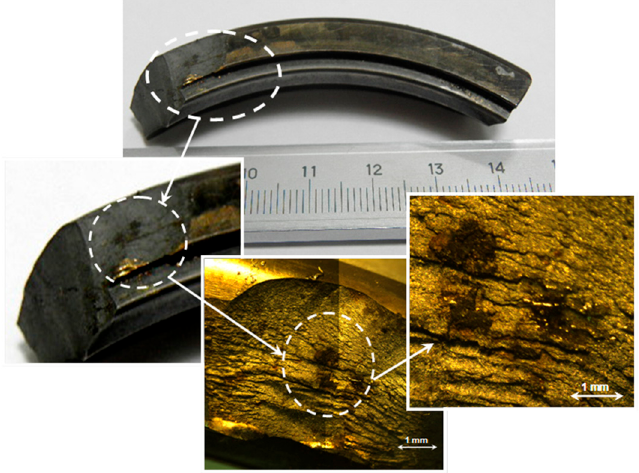
Figure 4. Stereoscopic images of a fragment of the failed outer ring, exhibiting geometric irregularities.